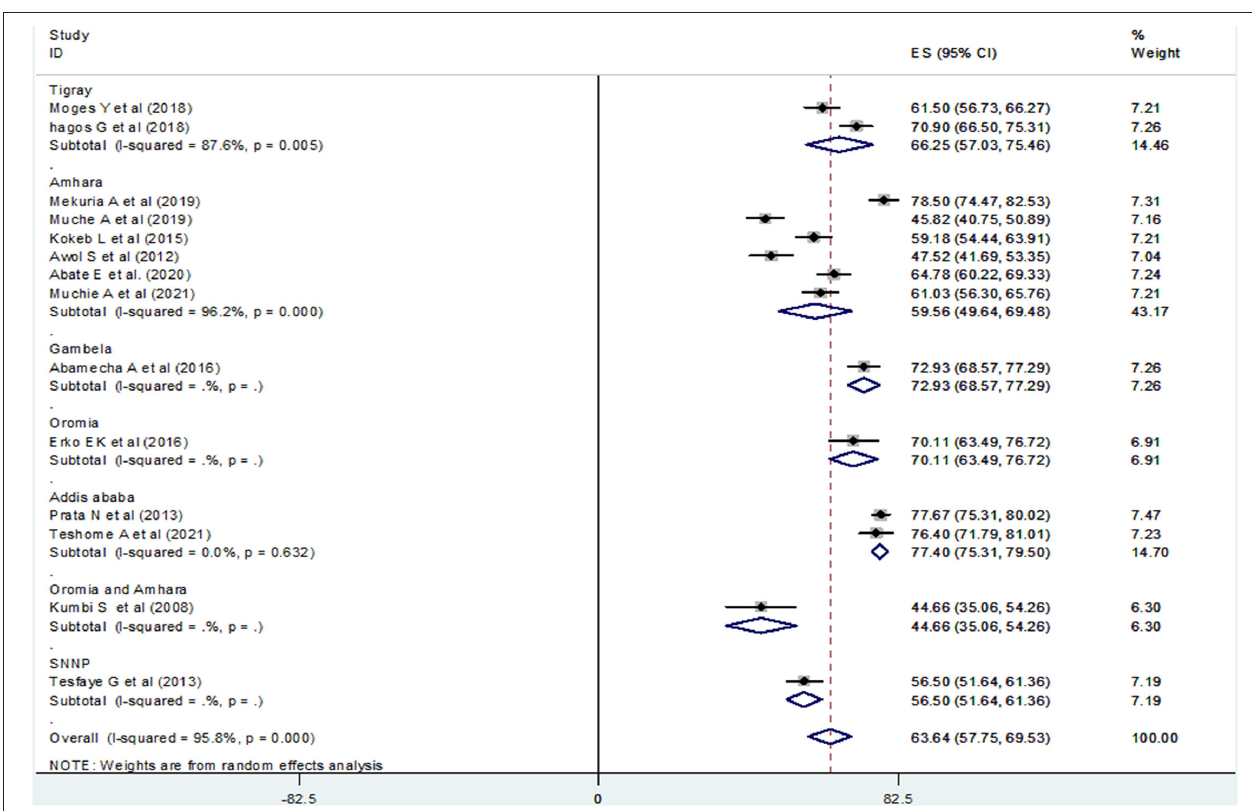
FIGURE 4 | Forest plot of the prevalence of PAFP with corresponding 95% CIs of the subgroup analysis based on the regions in